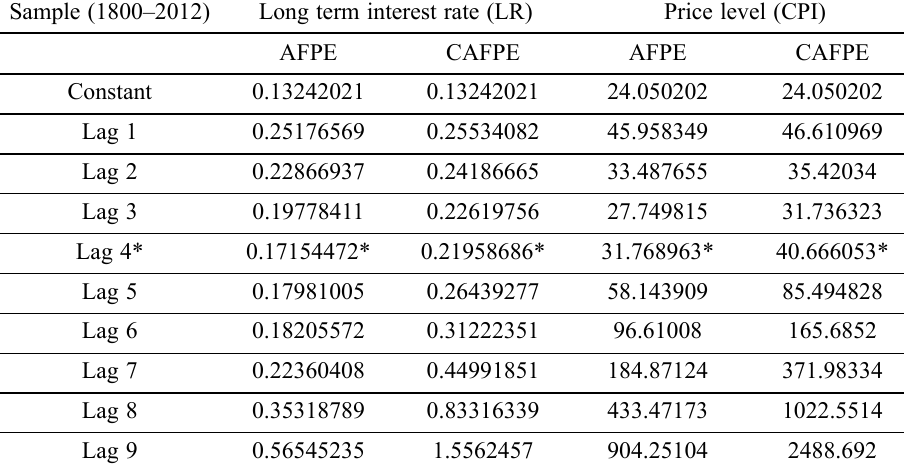
Table 9. Nonparametric Lag Selection (NAR) for LR and CPI Sample